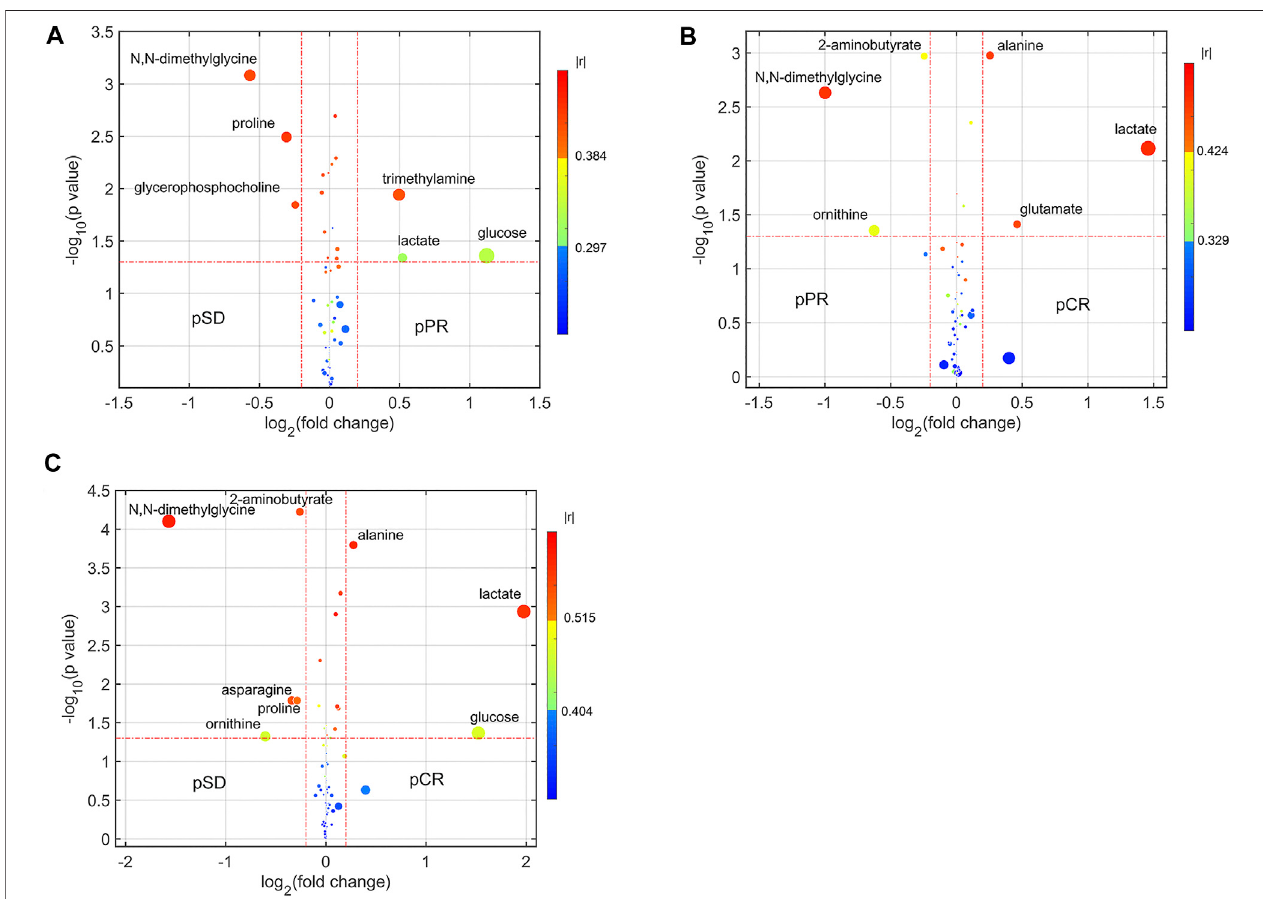
FIGURE 4 | Enhanced volcano plots showing signi fi cantly different metabolites: (A) pSD patients vs. pPR patients; (B) pPR patients vs. pCR patients; (C) pSD patientsvs.pCRpatients.Thevolcanoplotshowslog 2 (foldchange)onthe x -axisand-log 10 ( p value)onthey-axis.Eachpointrepresentsametabolite.Circles ’ sizeand coloraredeterminedbasedonthevariableimportanceinprojection(VIP)andabsolutecorrelationcoef fi cientvalues(|r|),respectively.Foreachcomparison,thelargerthe VIP value, the larger the size of the circle, and the warmer color corresponds to higher |r|; the gradient blue means |r| is less than 0.297; the gradual bright yellow means |r| is greater than 0.297 and is less than 0.384; the gradient red means |r| is greater than